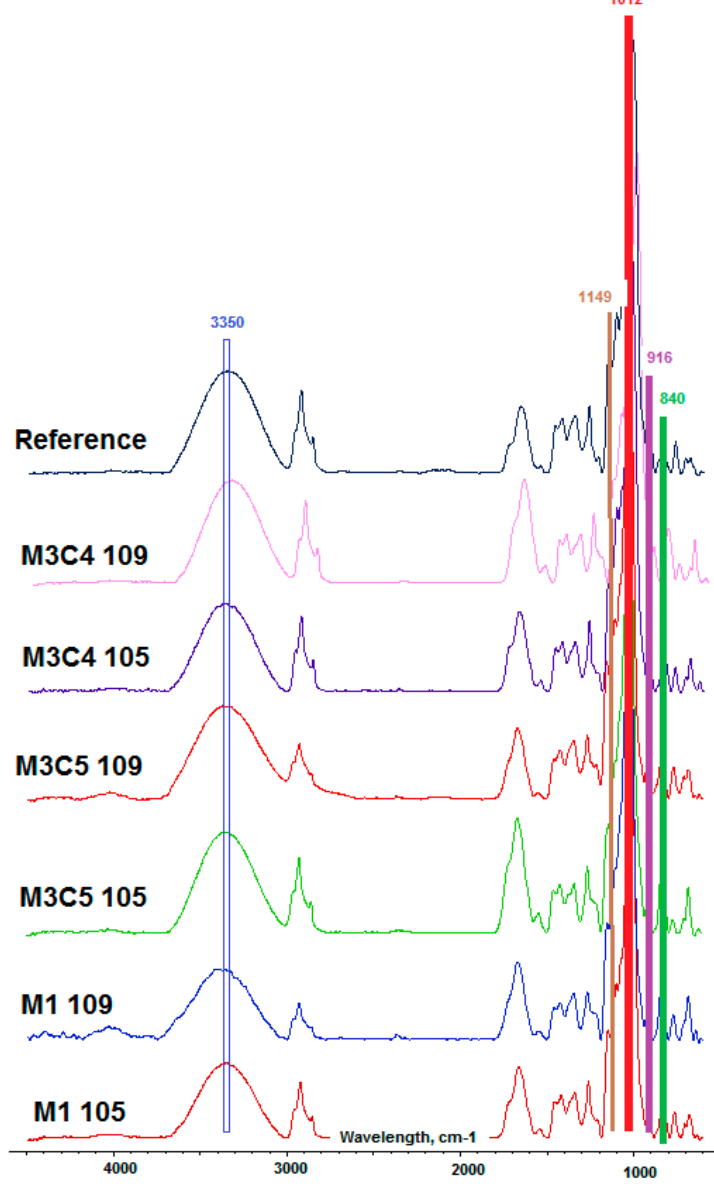
Figure 3. The FTIR spectra recorded for the studied EPS samples.